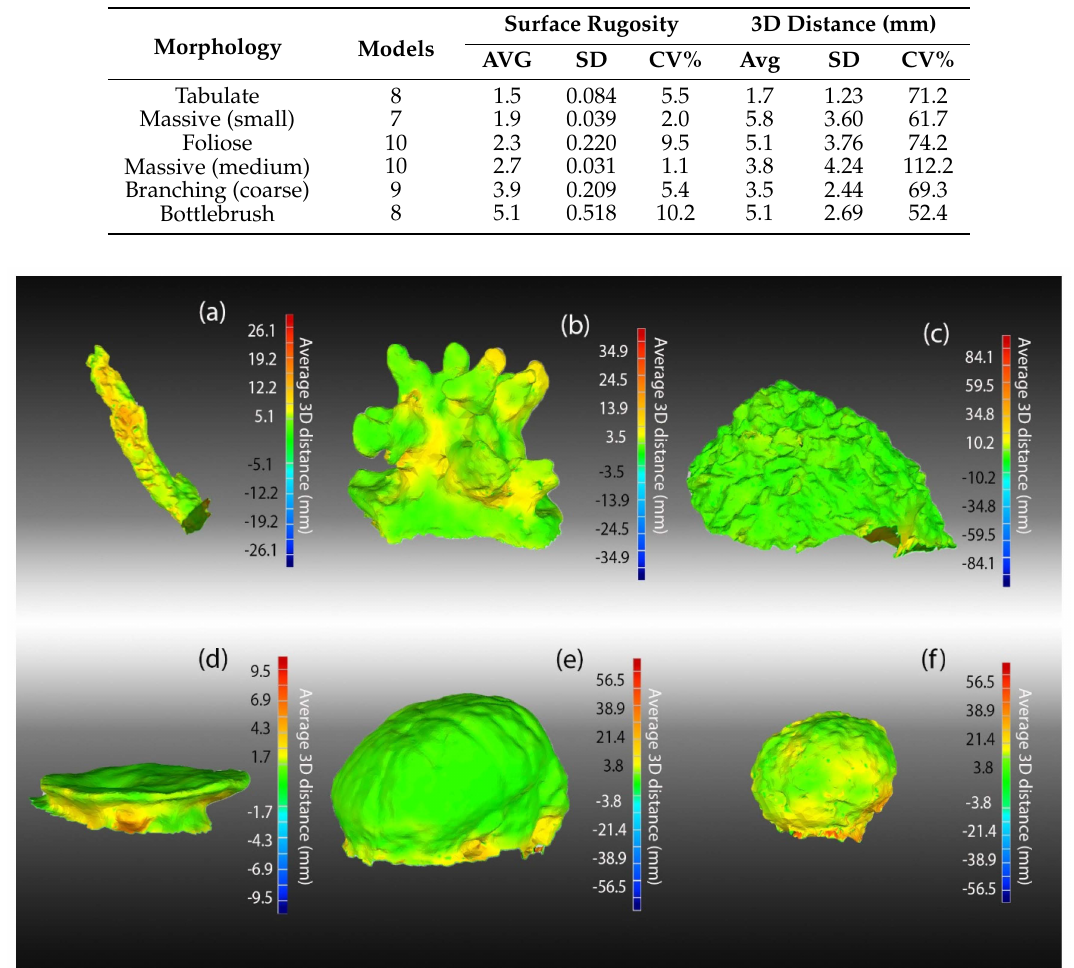
Table 2. Summary of precision analysis of coral colonies with the average and standard deviation from comparison on surface rugosity values from models, and the distance between the 3D models per morphology.